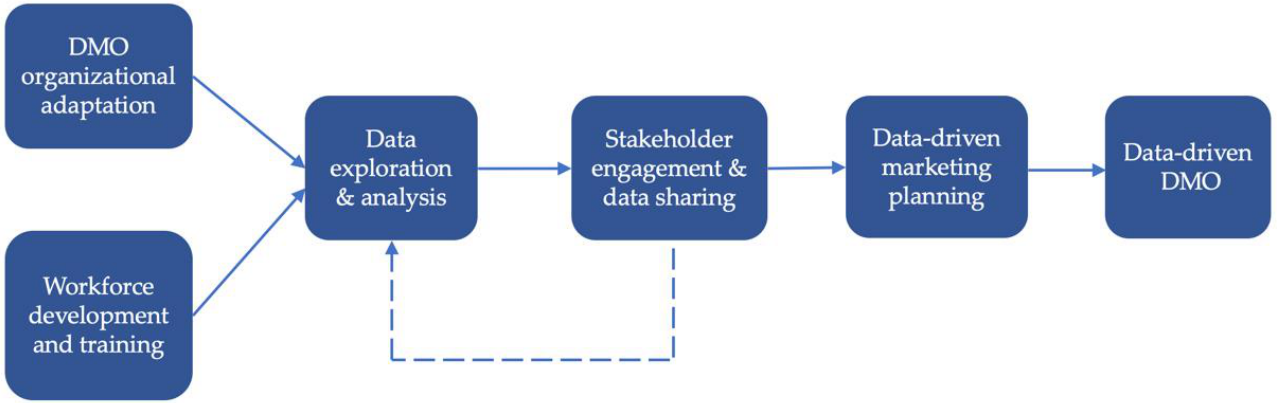
Figure 1. A framework for advancing DMOs’ data-driven decision-making.